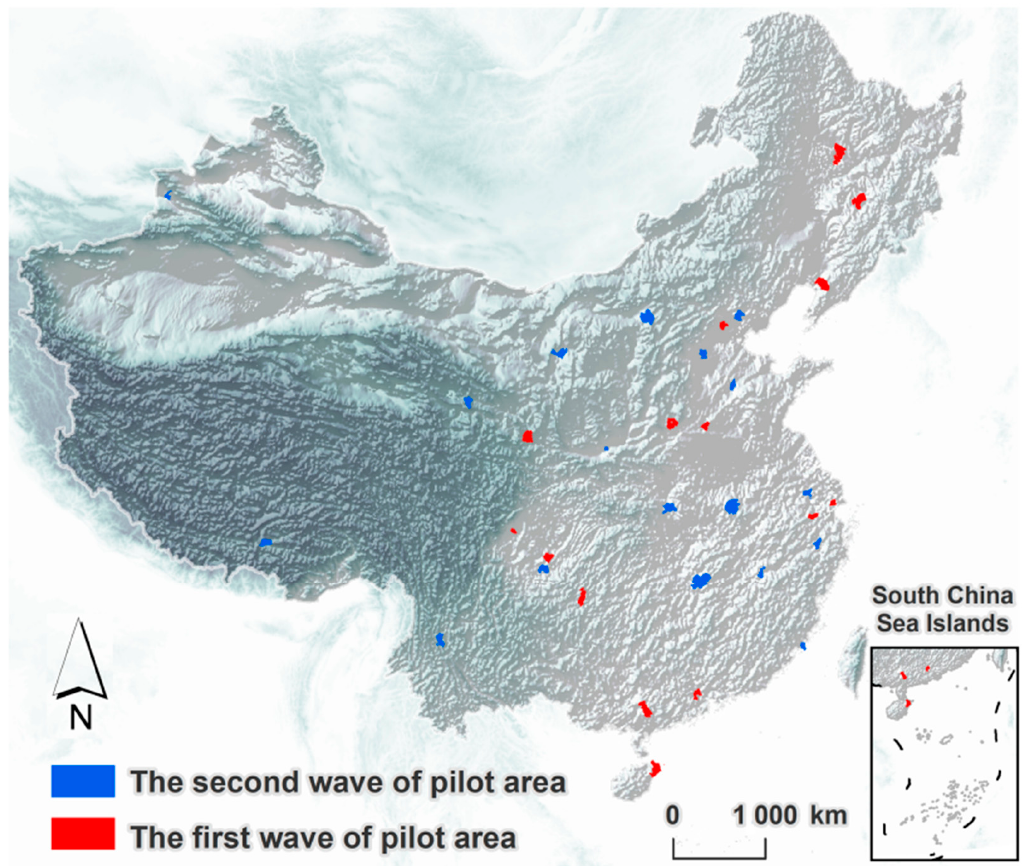
Figure 1. Geographical distribution of pilot areas.